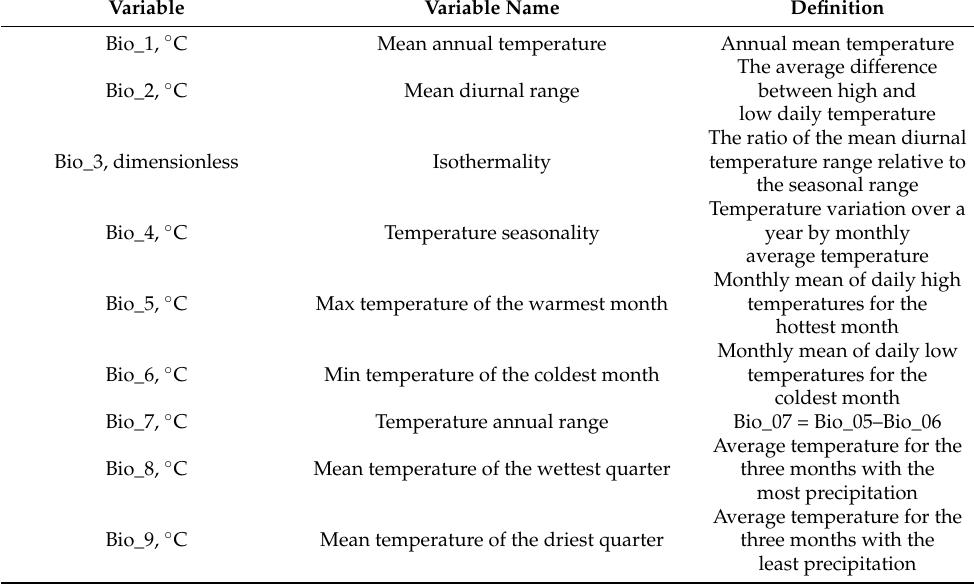
Table 2. Bioclimatic